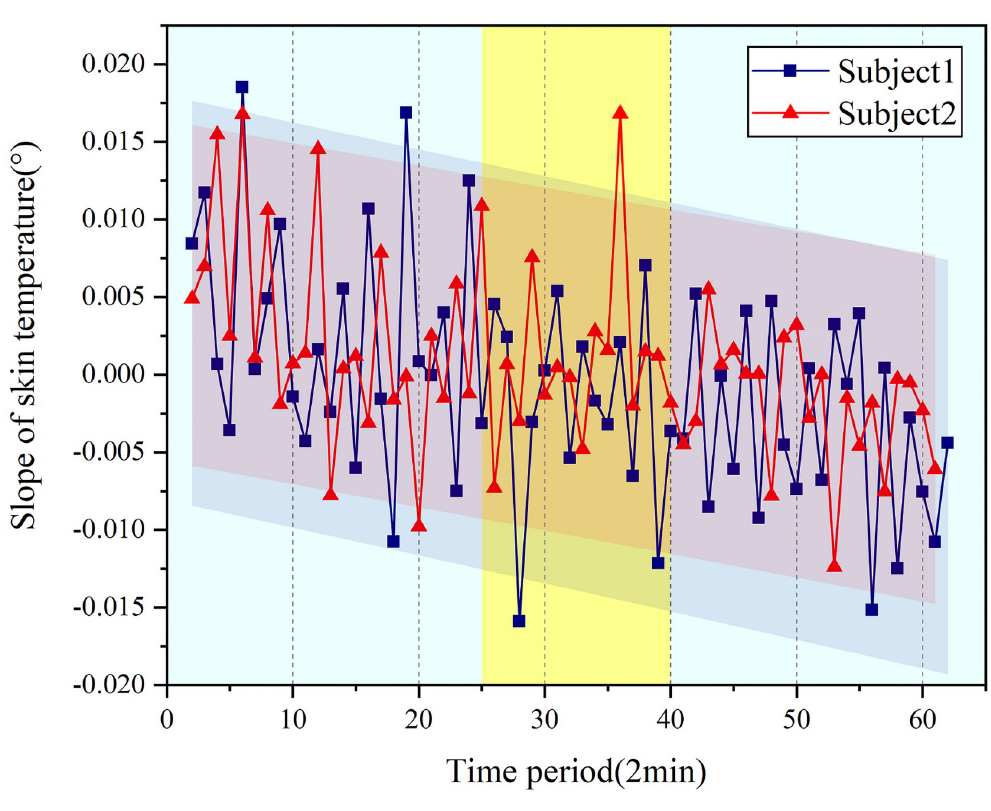
Fig 12. Trend of skin temperature slope.